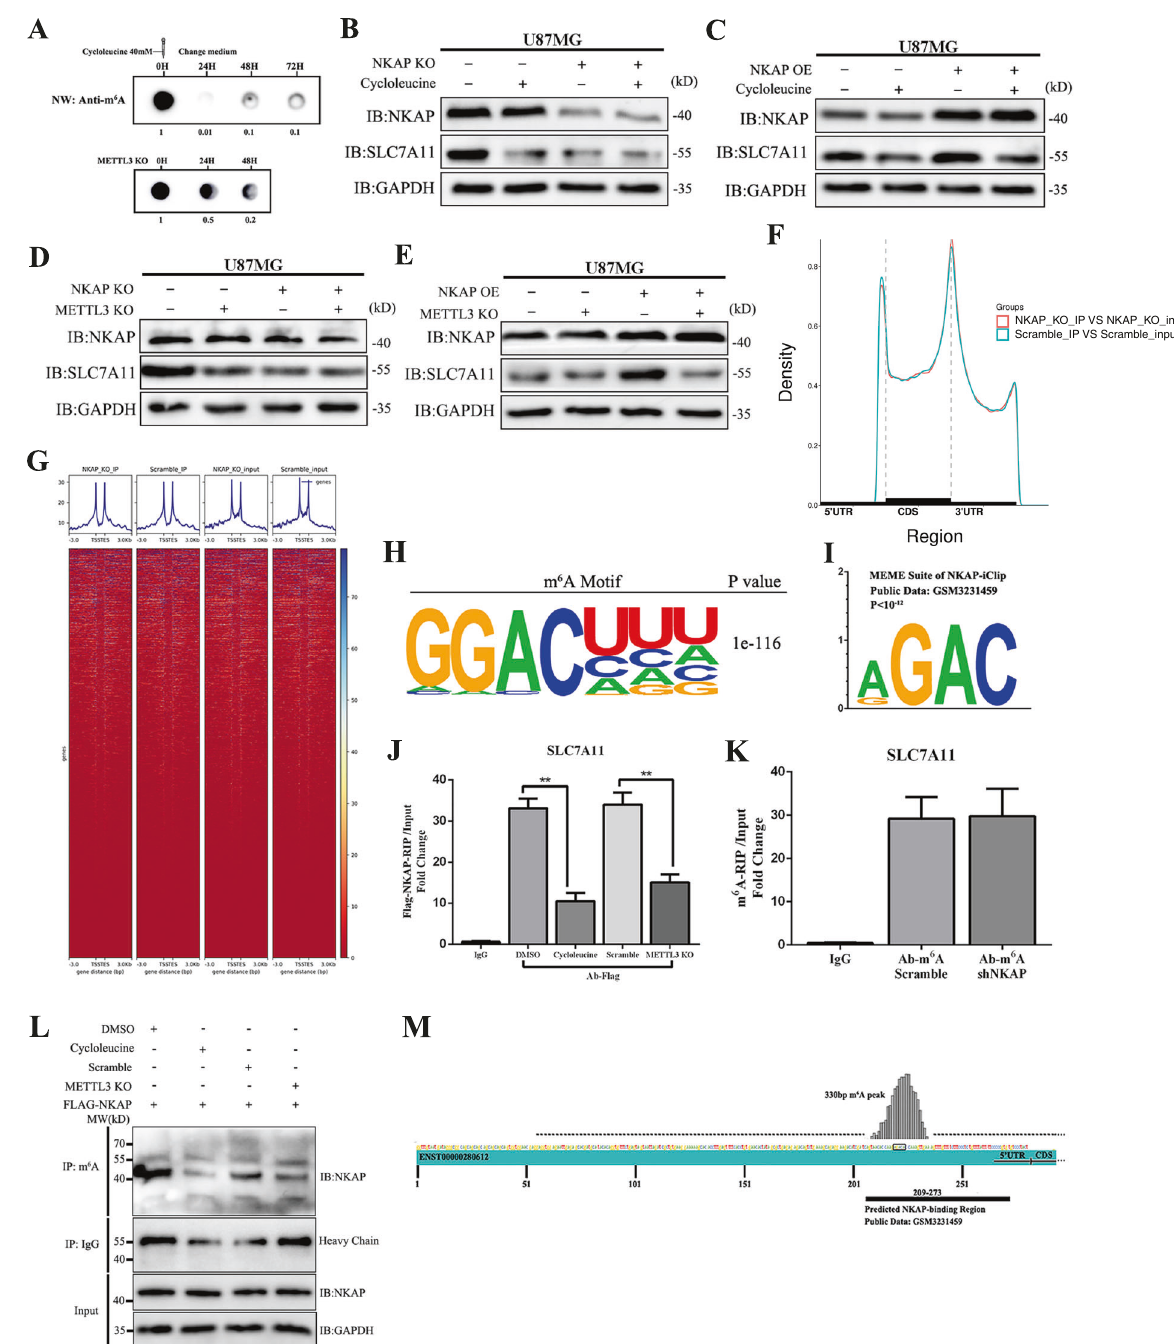
Fig. 5 Binding to m 6 A was necessary for NKAP to promote SLC7A11 expression. A m 6 A northwestern blot assay was performed using an equal amount of RNA (1 μ g) isolated from each group. Brie fl y, the cells were treated with 40 μ M cycloleucine for 24 h until the change of culture media. B Western blot assay showed SLC7A11 protein expression regulated by NKAP knockdown and 40 μ M cycloleucine for 24 h. C SLC7A11 protein expression regulated by NKAP overexpression and 40 μ M cycloleucine for 24 h. D SLC7A11 protein expression is regulated by NKAP knockdown and METTL3 knockdown. E SLC7A11 protein expression regulated by NKAP overexpression and METTL3 knockdown. F Similar m 6 A peak density in the 5 ʹ -UTR, CDS, and 3 ʹ -UTR regions in the scramble and shNKAP groups. G Enrichment of reads near the transcription start site (TSS) and transcription end site (TES). H HOMER identi fi ed the m 6 A consensus motif in the U87MG cells as “ RGACH ” . I MEME SUIT analyzed NKAP footprints as the “ RGAC ” motif based on the NKAP-iCLIP public data. J FLAG-NKAP-RIP revealed that enrichment of SLC7A11 mRNA signi fi cantly decreased in the cycloleucine-treated and METTL3 knockdown groups. K m 6 A-RIP showed no signi fi cant difference in SLC7A11 mRNA enrichment between the scramble and shNKAP groups. L Co-IP analysis of the interaction between m 6 A and Flag-NKAP in U87MG cells. M m 6 A-seq showed that the m 6 A peak in the SLC7A11 transcript ENST00000613322 had an overlap with the predicted NKAP binding region. GAPDH was used as an internal control in western blot. All bars show mean ± SD of three independent experiments. * P < 0.05, ** P <